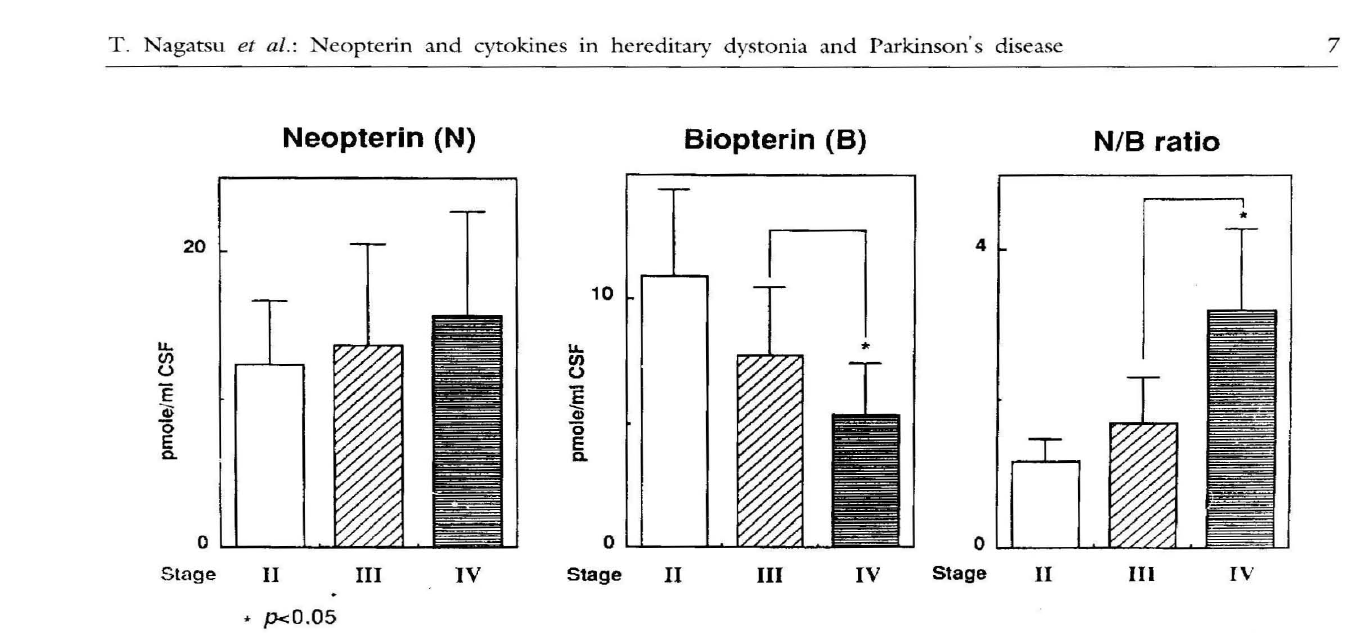
Figure 2. Neopterin, biopterin and neopterin/ biopterin ratio in cerebrospinal fluid of patients with Parkinson's disease at various stages (6